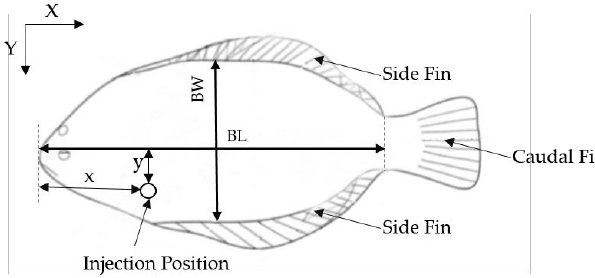
Figure 3. The measurement method for turbot body-shape parameters.